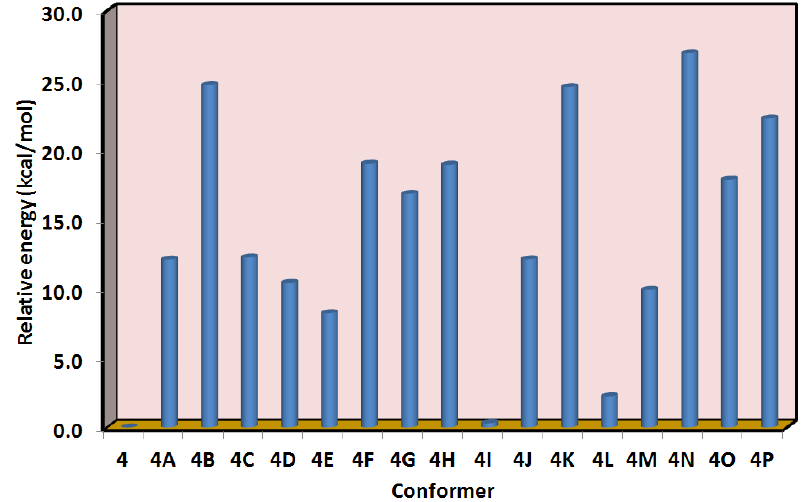
Figure 9. Relative energy of the suggested conformers of 4 compared to the most stable one.